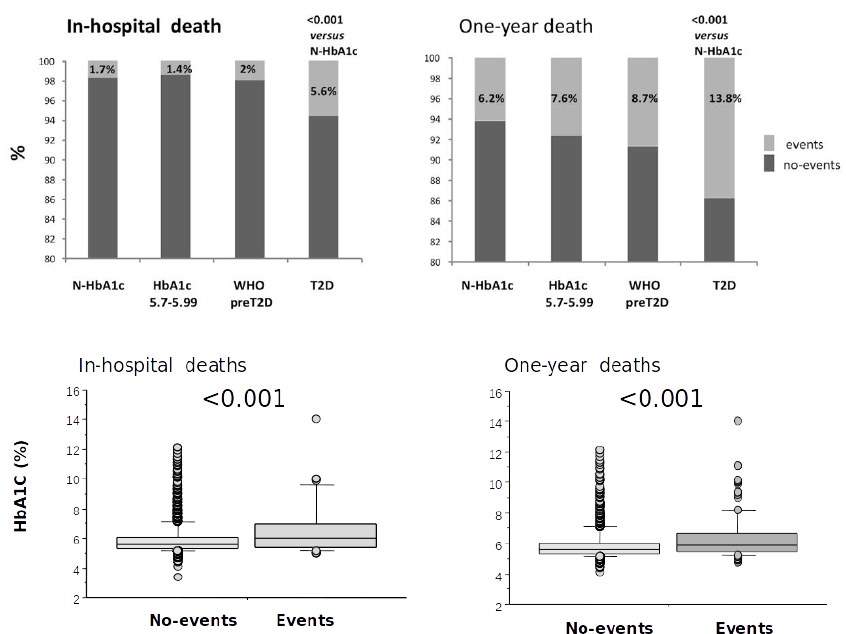
Figure 3. In-hospital and one-year death according to HbA1C, when evaluated as categorical rather than continuous variable (upper and lower panels, respectively). than continuous variable (upper and lower panels,